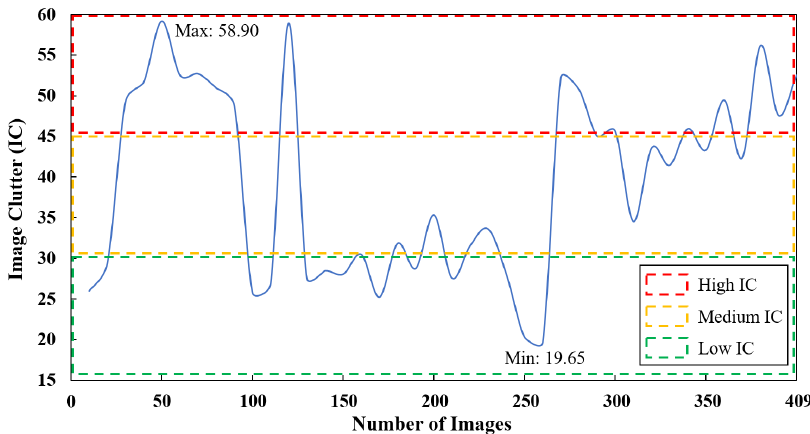
Figure 1. The IC distribution of power line images.